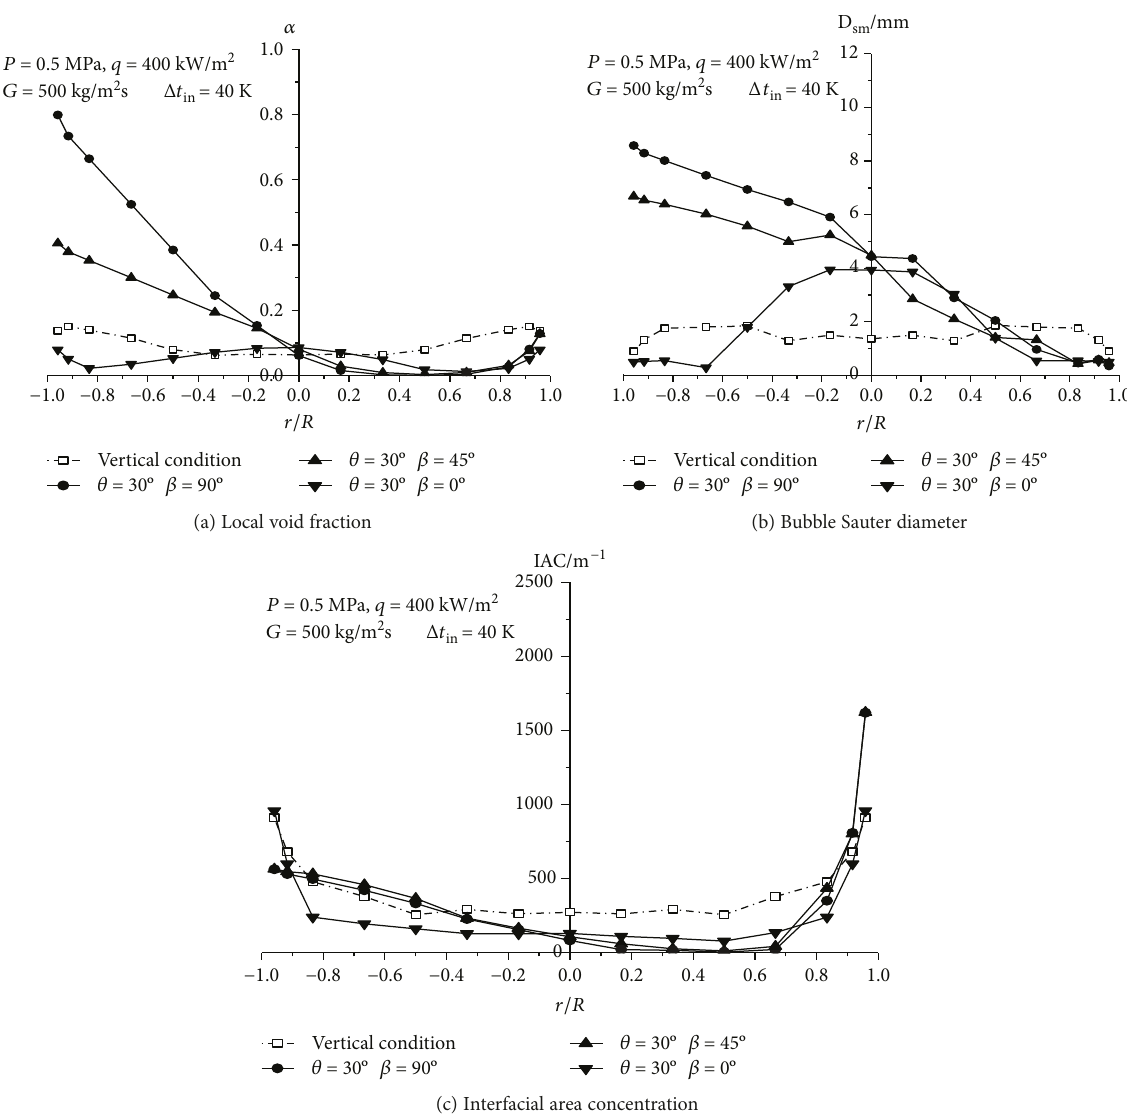
Figure 5: Phase distribution of subcooled fl ow boiling under inclined